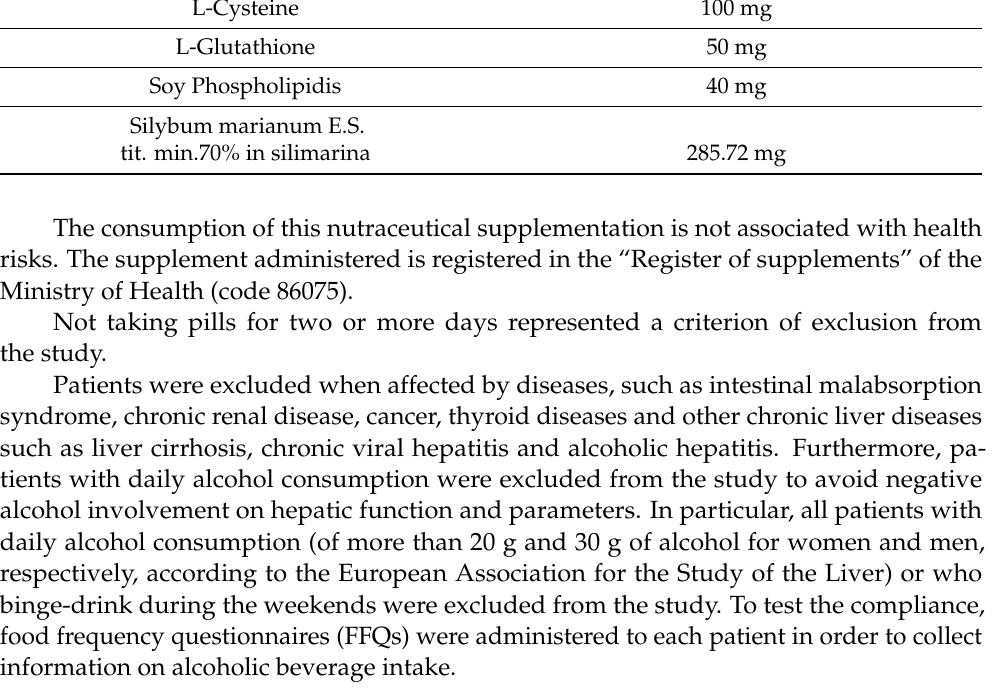
Nutritional Information